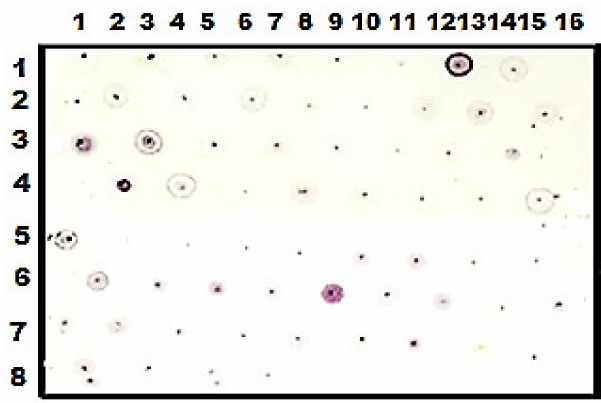
Figure 4. Orcinol / H 2 SO 4 test of the obtained fractions of RvH1 after